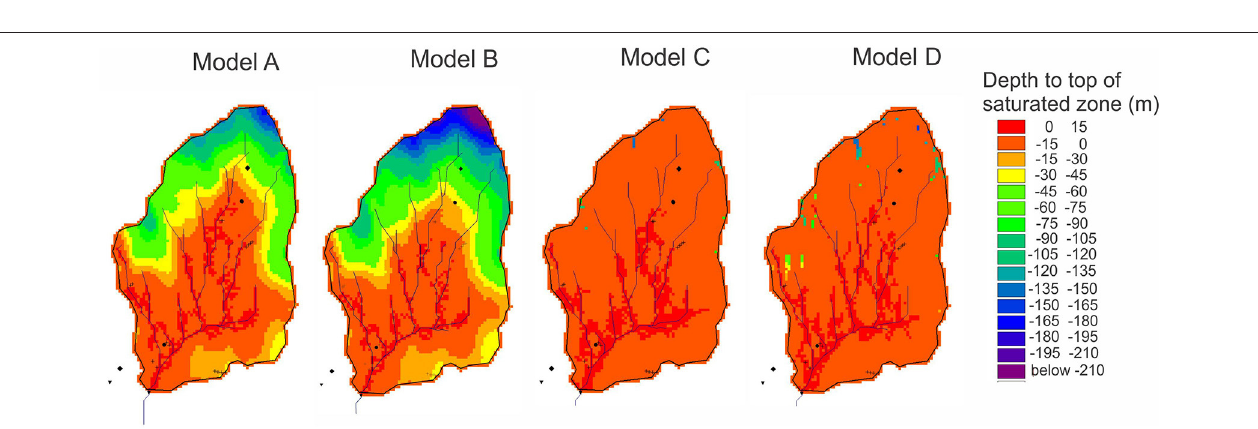
FIGURE 11 | Simulated depth to the top of saturated zone on June 18, 2010 for Model A, Model B, Model C, and Model D.